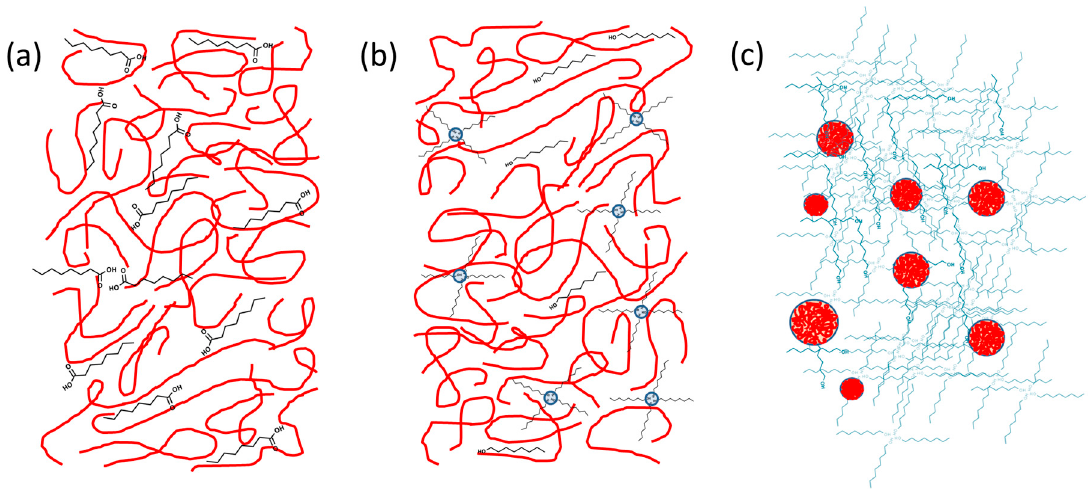
Figure 10. Viscosity-inspired (not to scale) schematic representations of silicone oil (in red) mixtures, showing the intercalation of ( a ) octanoic acid molecules (in black) and ( b ) octanol molecules and tetramers (each shown in blue). In ( c ), phase-separated silicone oil droplets (red) in octanol (blue) are shown.